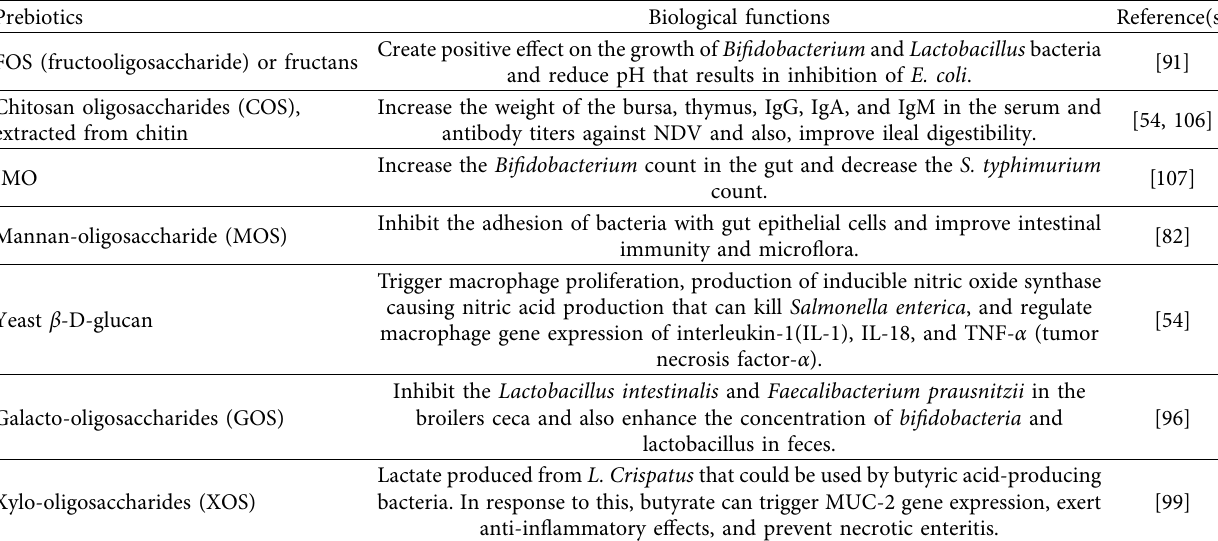
Table 2: Prebiotics and their biological